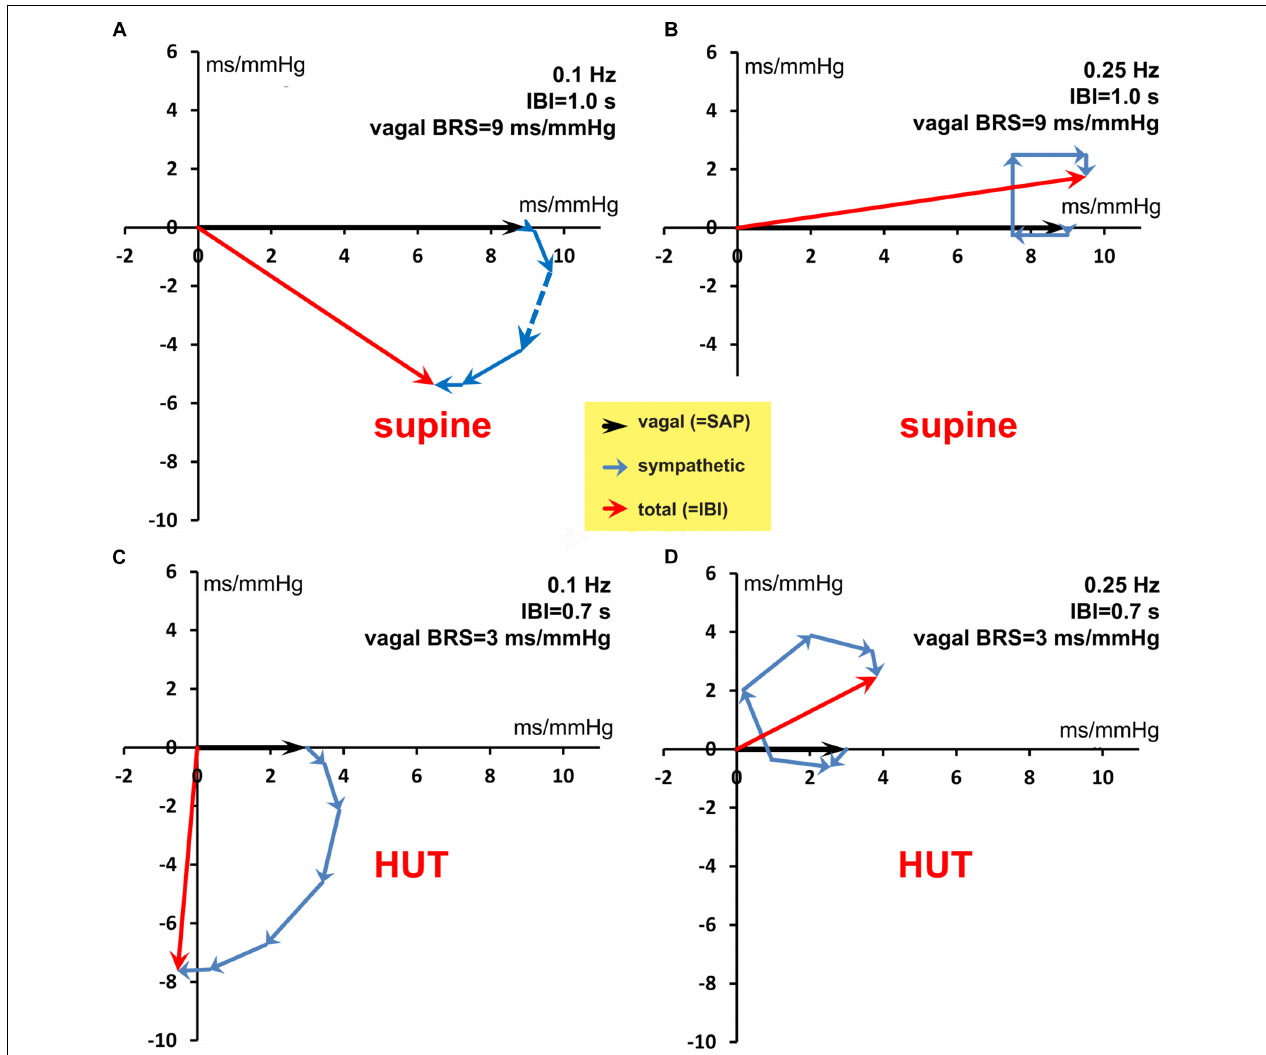
FIGURE 8 | Vector addition of the frequency-dependent vagal and sympathetic BRS contributions for simulated data. The black vector indicates the vagal BRS contribution, coinciding in phase with the SAP variation. The blue vectors are the sympathetic BRS contributions, varying in size and direction, as suggested by Figure 1 . The sum of vagal and sympathetic contributions determines the total BRS-vector (red), which controls the IBI-variations, the phase of which differs in general from the SAP phase. (A,B) are for the simulated supine conditions, with frequency 0.1 and 0.25 Hz, respectively. The orientation and size of the dashed vector in (A) is explained in detail in the text. (C,D) are for the HUT condition, with faster IBI and less vagal contribution. The figure shows that a variety of phase angles and BRS magnitudes can result from the combination of vagal and sympathetic